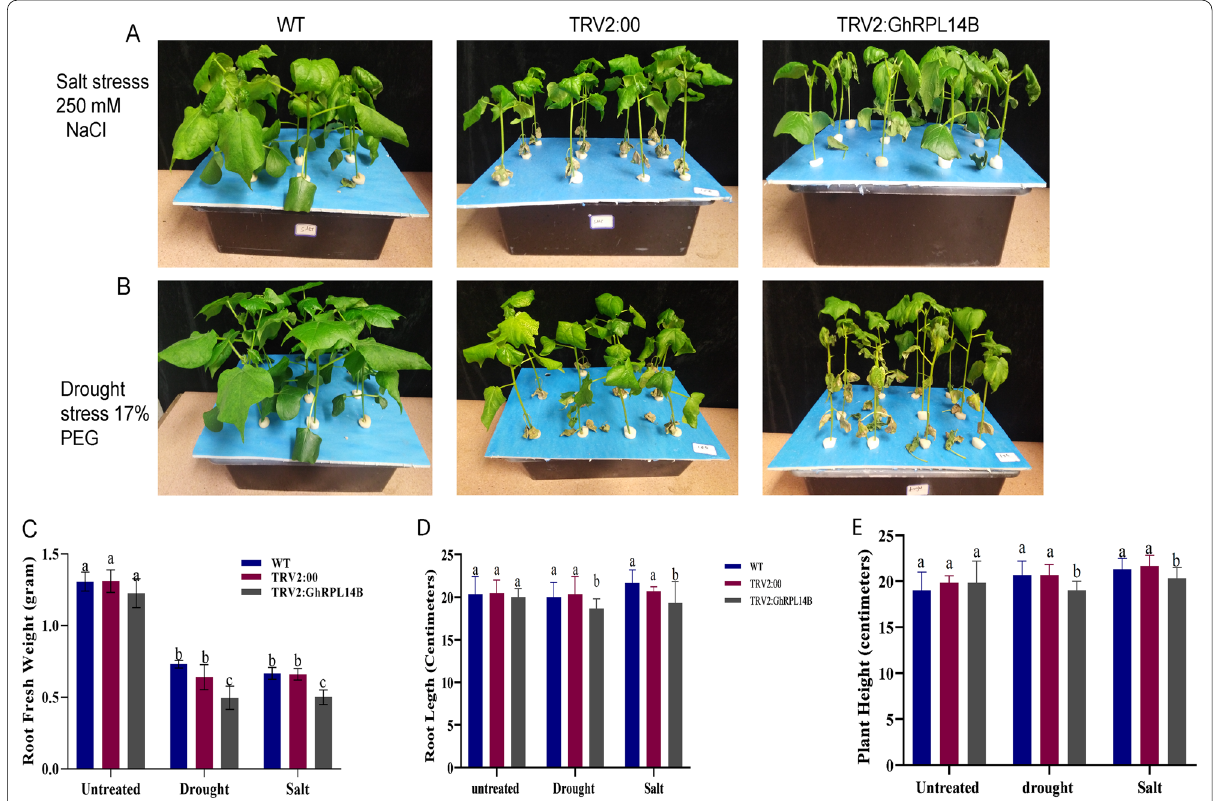
Fig. 8 Morphological evaluation of the VIGS-plants and the wild types (WT) under drought and salt stress conditions. A Phenotype observation of TRV2: GhRPL14B, TRV2:00 and WT 24 h after (250 mmol L –1 NaCl) salt treatment. B Phenotype observation of TRV2: GhRPL14B, TRV2:00 24 h after · 17% PEG treatment. Morphological parameters, C root fresh weight (RFW), D root length (RL), and E plant height (PH). Bar indicates the standard error (SE). Different letters indicate the significant differences between the wild type (WT) and VIGS-plants (ANOVA; P <